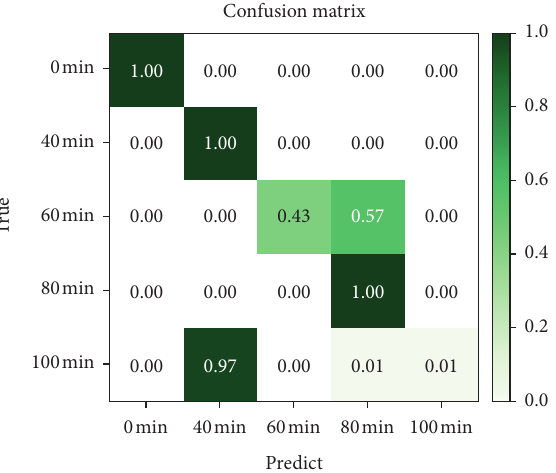
Figure 11: Confusion matrix of lowest accuracy using